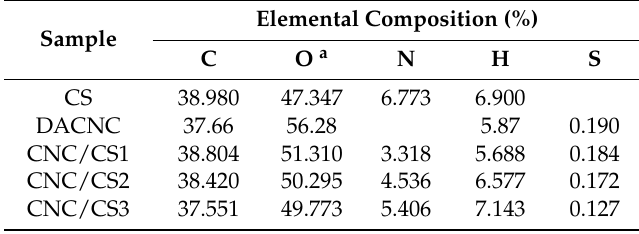
Table 1. Elemental analysis of cellulose nanocrystal/chitosan (CNC/CS) hydrogels.